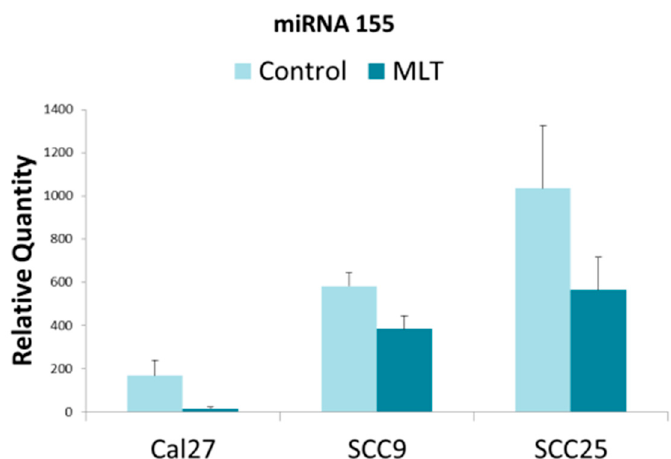
Figure 3. Relative miR-155 expression in oral cancers under melatonin (MLT) administration. Histogram of quantitative PCR from cDNAs derived from extracellular vesicles demonstrated differential baseline expression of miR-155 including standard deviation (SD). Administration of melatonin significantly reduced expression of miR-155 in all three cell lines, p < 0.05 (CAL27, p < 0.001; SCC9, p = 0.003; SCC25, p = 0.039).